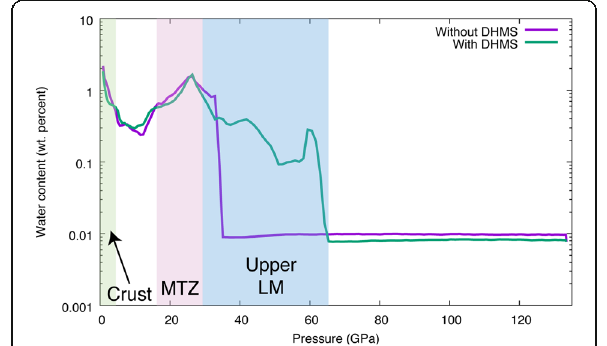
Fig. 2 Compositional (left) and hydrous (right) structures at t = 4.6 billion years. Top: without phase H (old look-up database); bottom: with DHMS solubility effects (new look-up database)